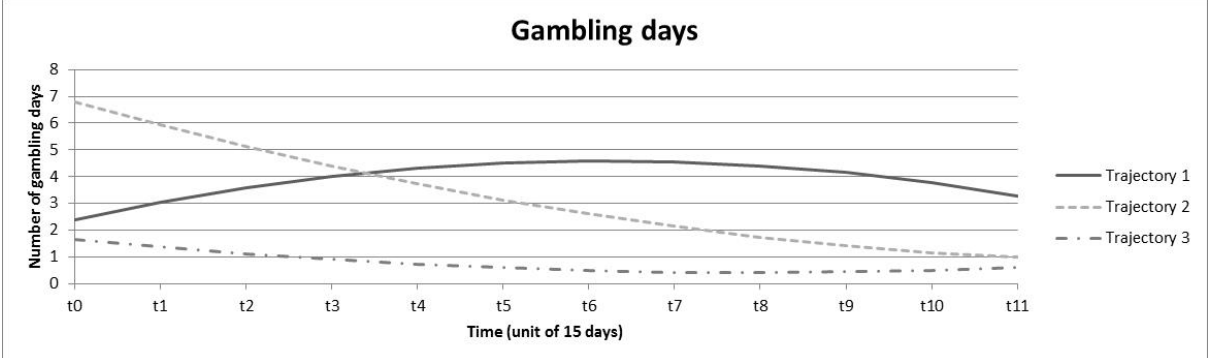
Figure 2. Trajectories obtained from growth mixture models for number of gambling days.